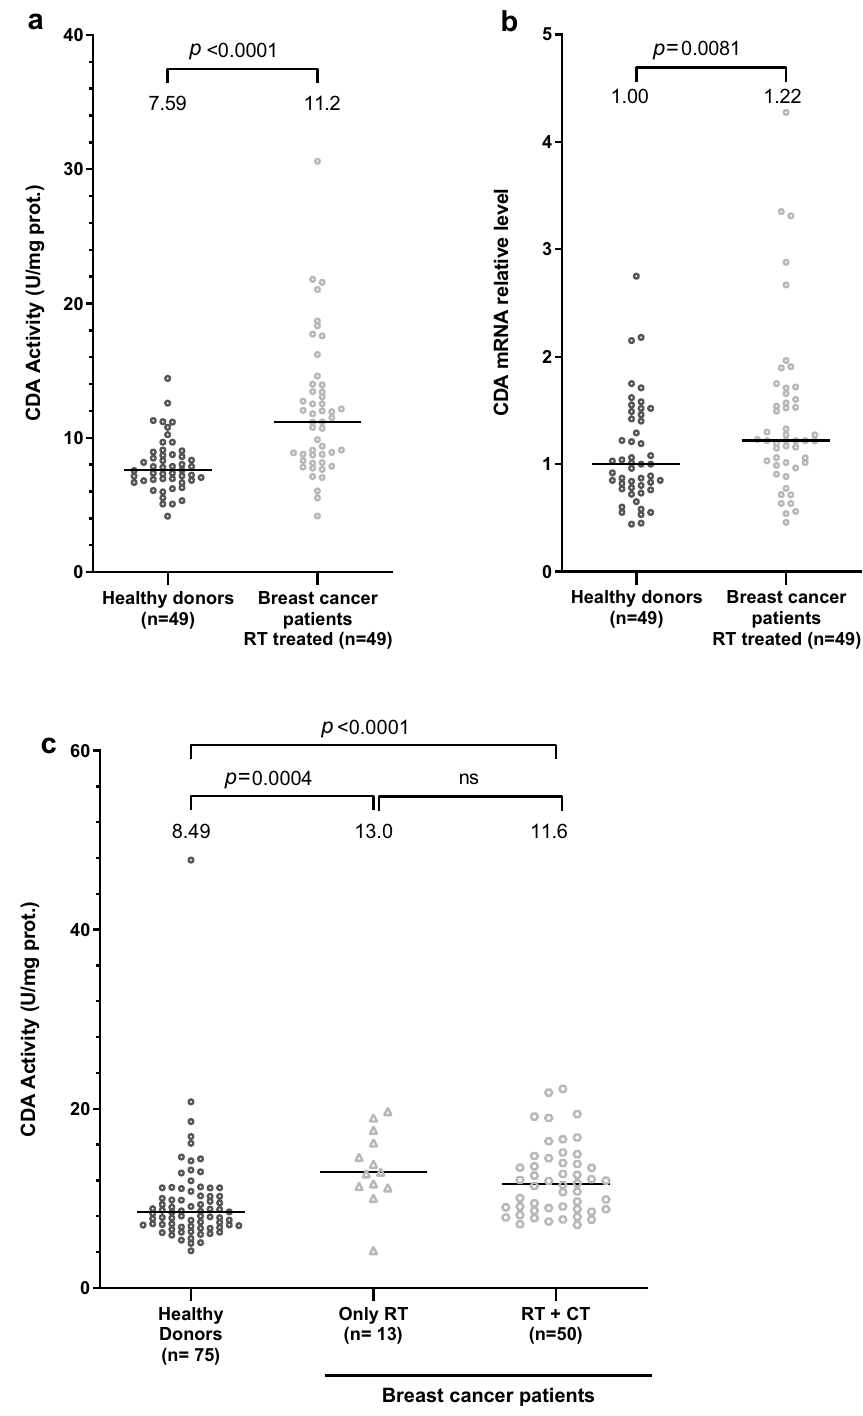
Figure 2. CDA activity and mRNA levels are significantly higher in serum samples from RT-treated BC patients than in those from untreated healthy donors. ( a ) Scatter plot representation of CDA activity in enzymatic units/mg of protein in matched healthy donors (in black) and RT-treated BC patients (in gray). ( b ) Scatter plot representation of relative levels of CDA mRNA in matched healthy donors (in black) and RT-treated BC patients (in gray). ( c ) Scatter plot representation of CDA activity in enzymatic units/mg of protein in healthy donors (in black) and BC patients treated with RT (with or without HT; triangle in gray), or treated with RT plus CT, (with or without HT; circle in gray) (one patient for whom we did not have CT treatment information was not included in this analysis). For each panel, medians are represented by black horizontal lines and are indicated above each distribution. n is the number of individuals. Distributions were compared in Kruskal– Wallis tests or in Wilcoxon matched-pairs signed-rank tests (see “Materials and methods” section). Values of p < 0.05 were considered statistically